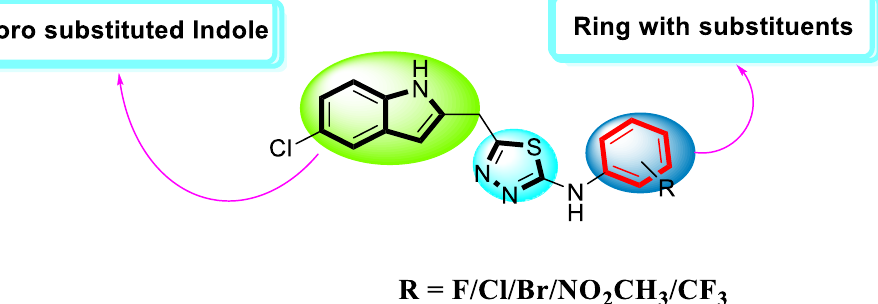
Figure 1. Representation of different parts of a molecule as an effective inhibitor of AchE and BuChE.